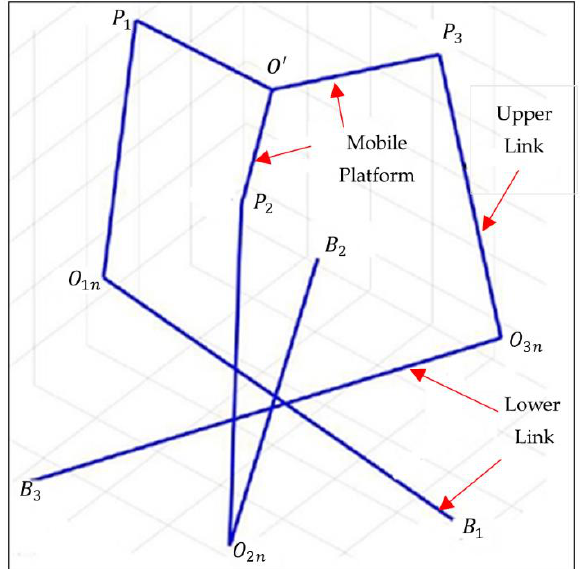
Figure 5. The data of the SPR.